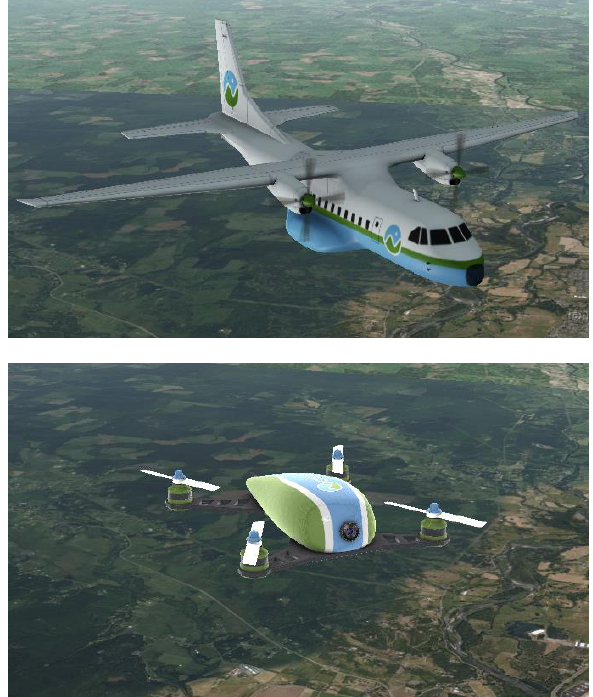
Figure 3 . The models for the airplane (above) and the UAV (below) defined in glTF format and used in the study.